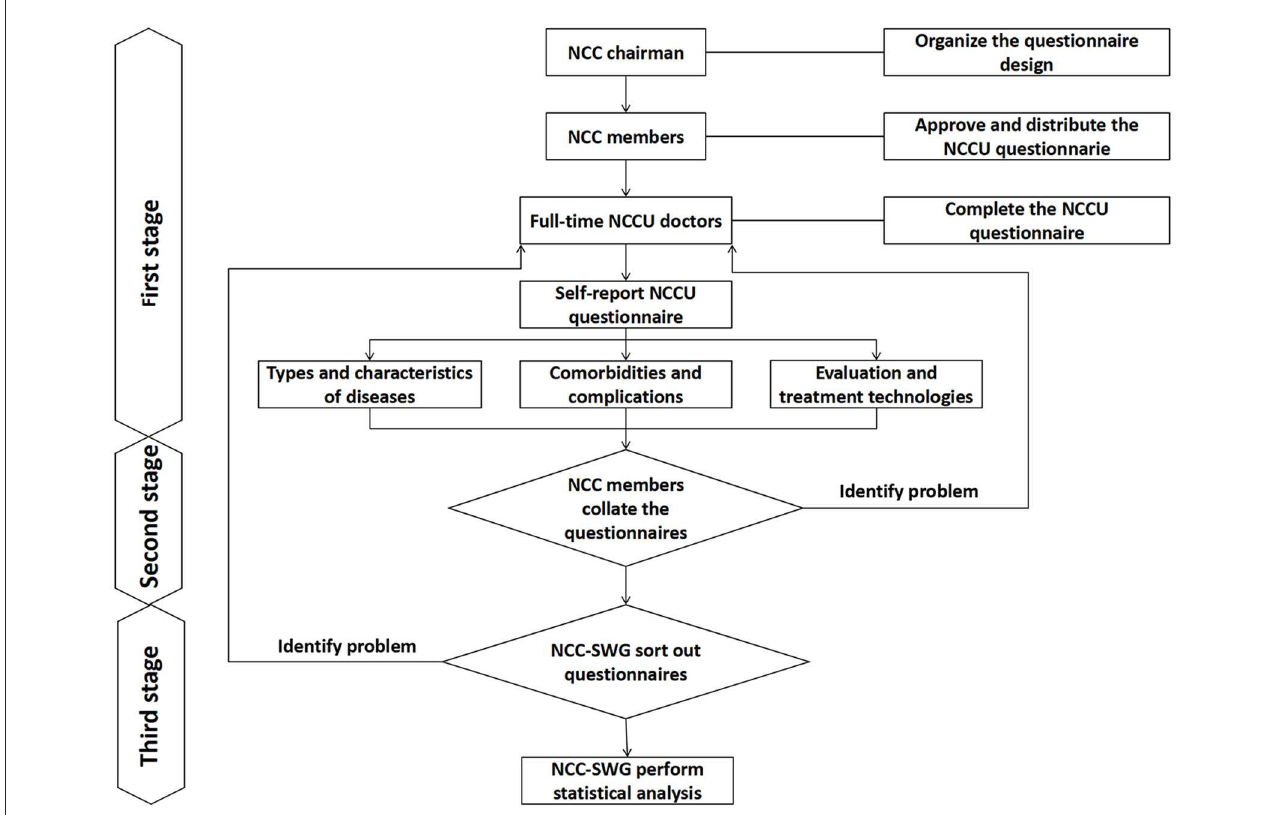
FIGURE1 Investigation process. NCC, neurocritical care; NCCU, neurocritical care unit.